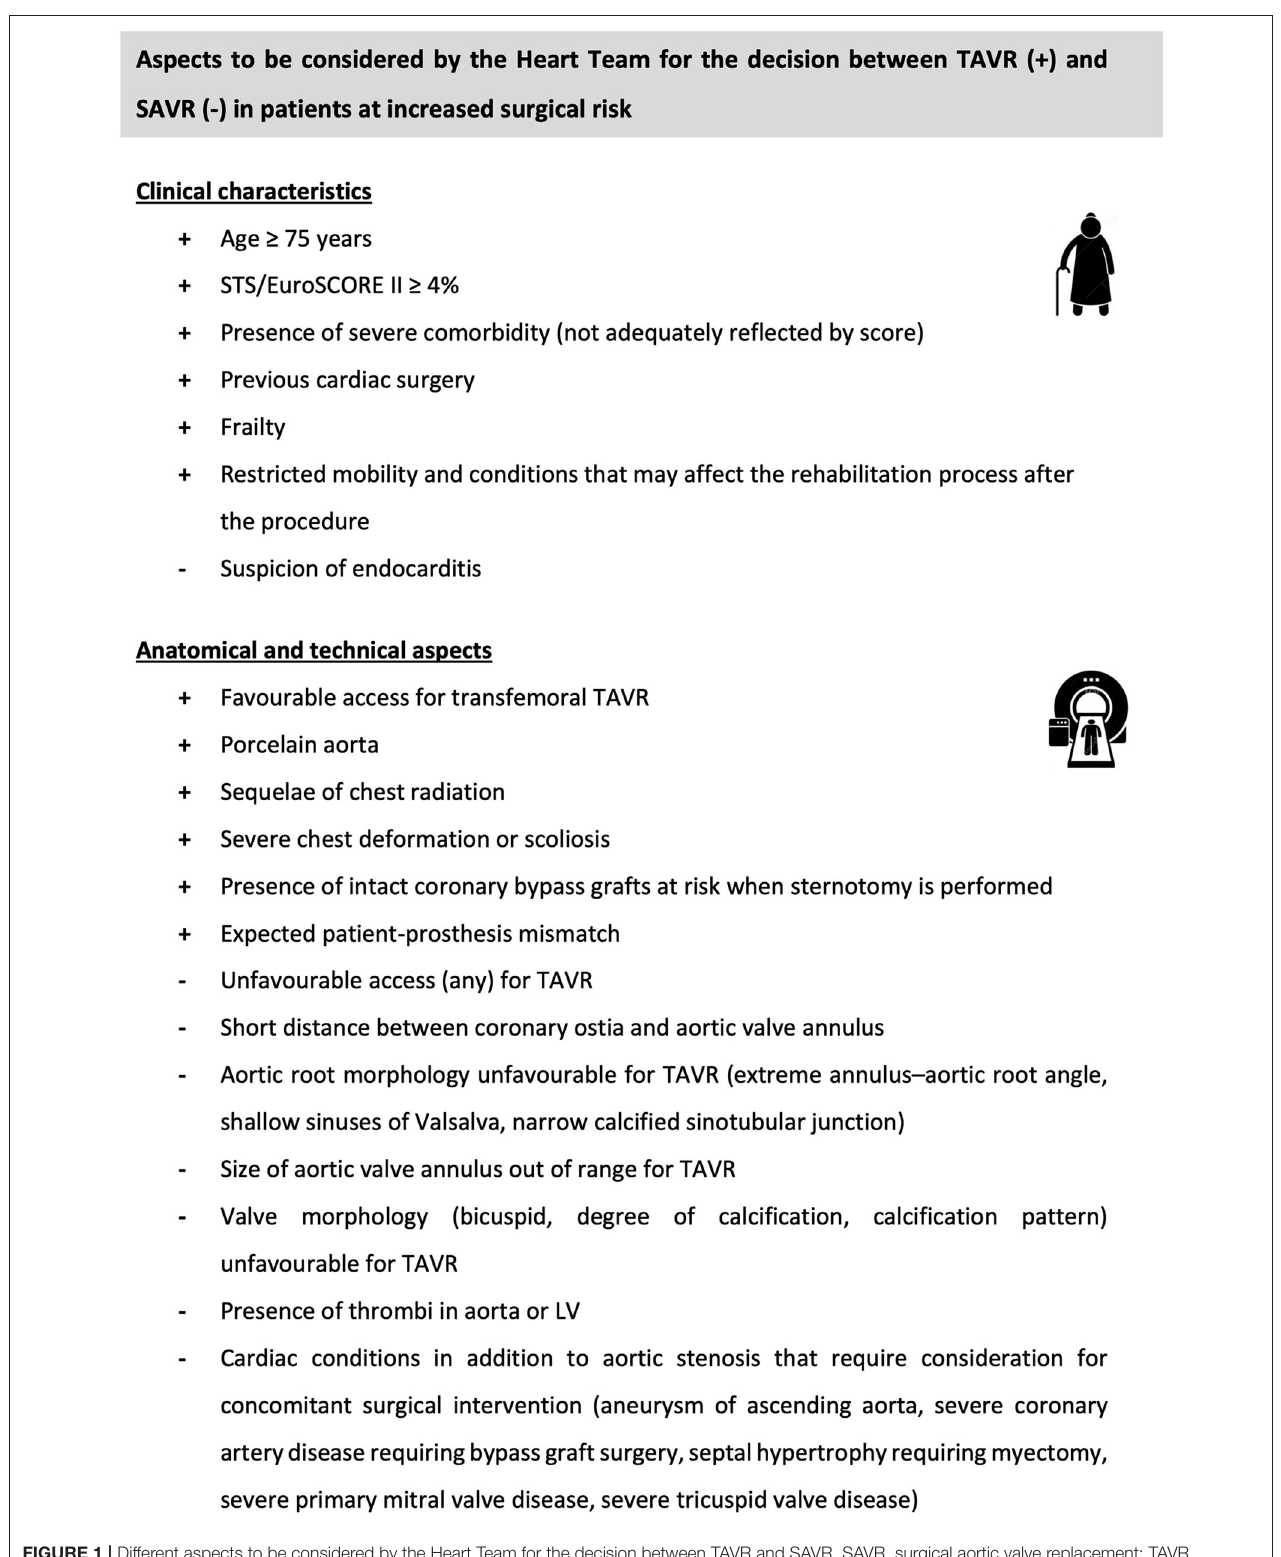
FIGURE 1 | Different aspects to be considered by the Heart Team for the decision between TAVR and SAVR. SAVR, surgical aortic valve replacement; TAVR, transcatheter aortic valve replacement.